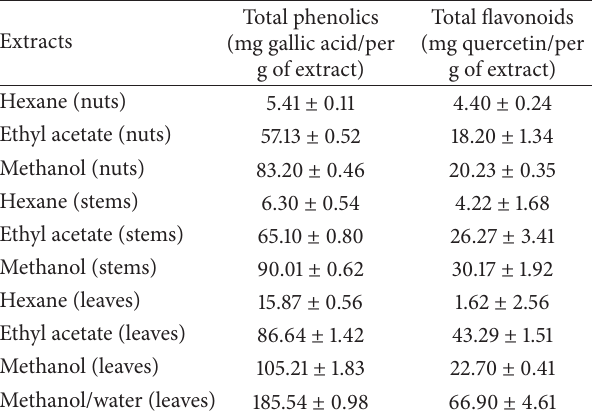
Table 4: Total phenolic and flavonoid contents in the different extracts from chetoui O. europaea variety.